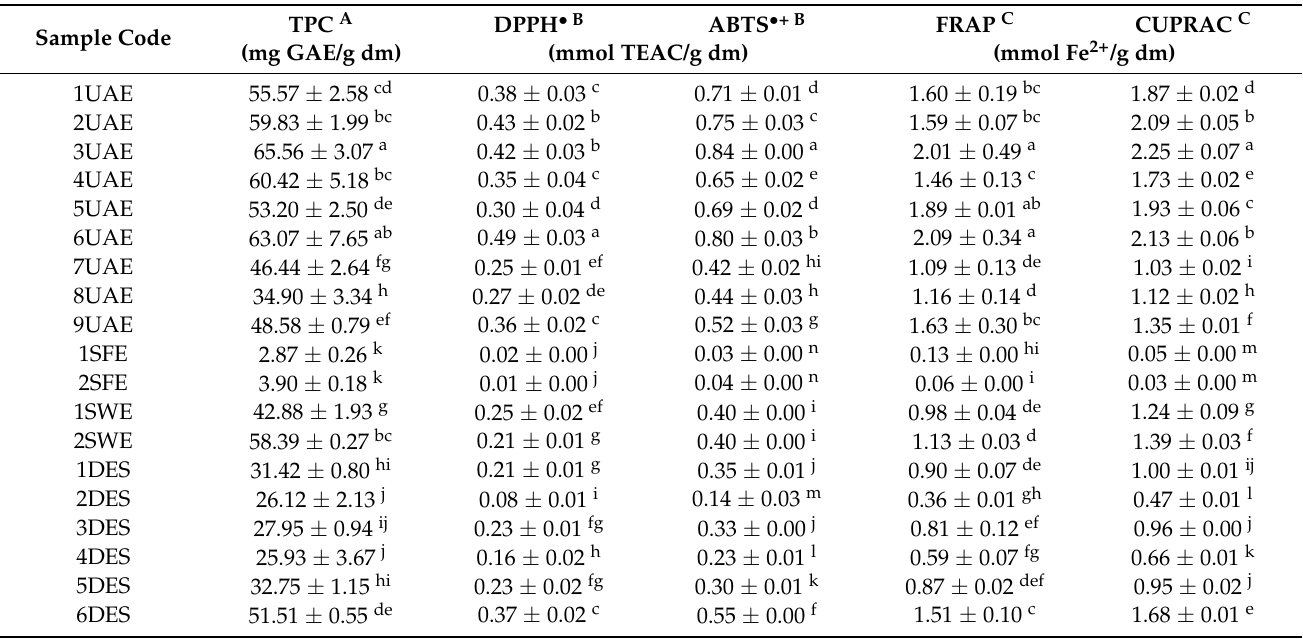
Table 3. Antioxidant activity of feijoa flower extracts obtained with selected different green extrac- tion